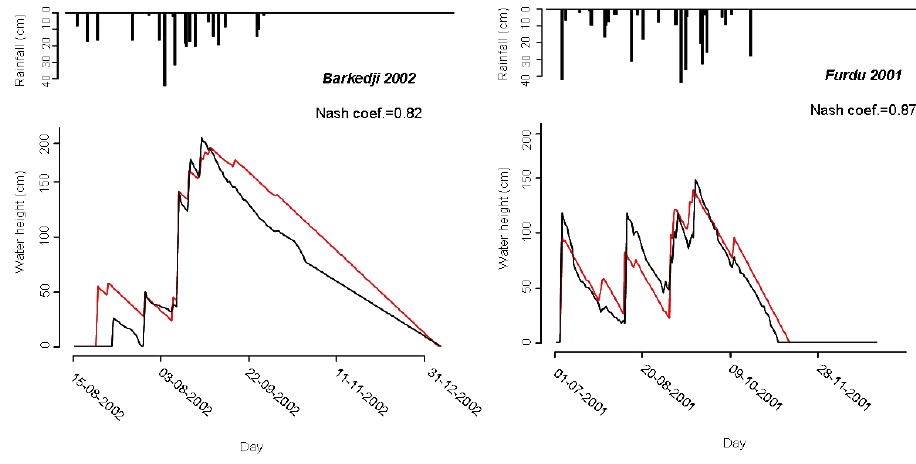
Fig. 5. Comparison of pond water height simulation (in red) using input parameters obtained from calibration, with water level records (in black) for Barkedji pond in 2002 (left) and Furdu pond in 2001